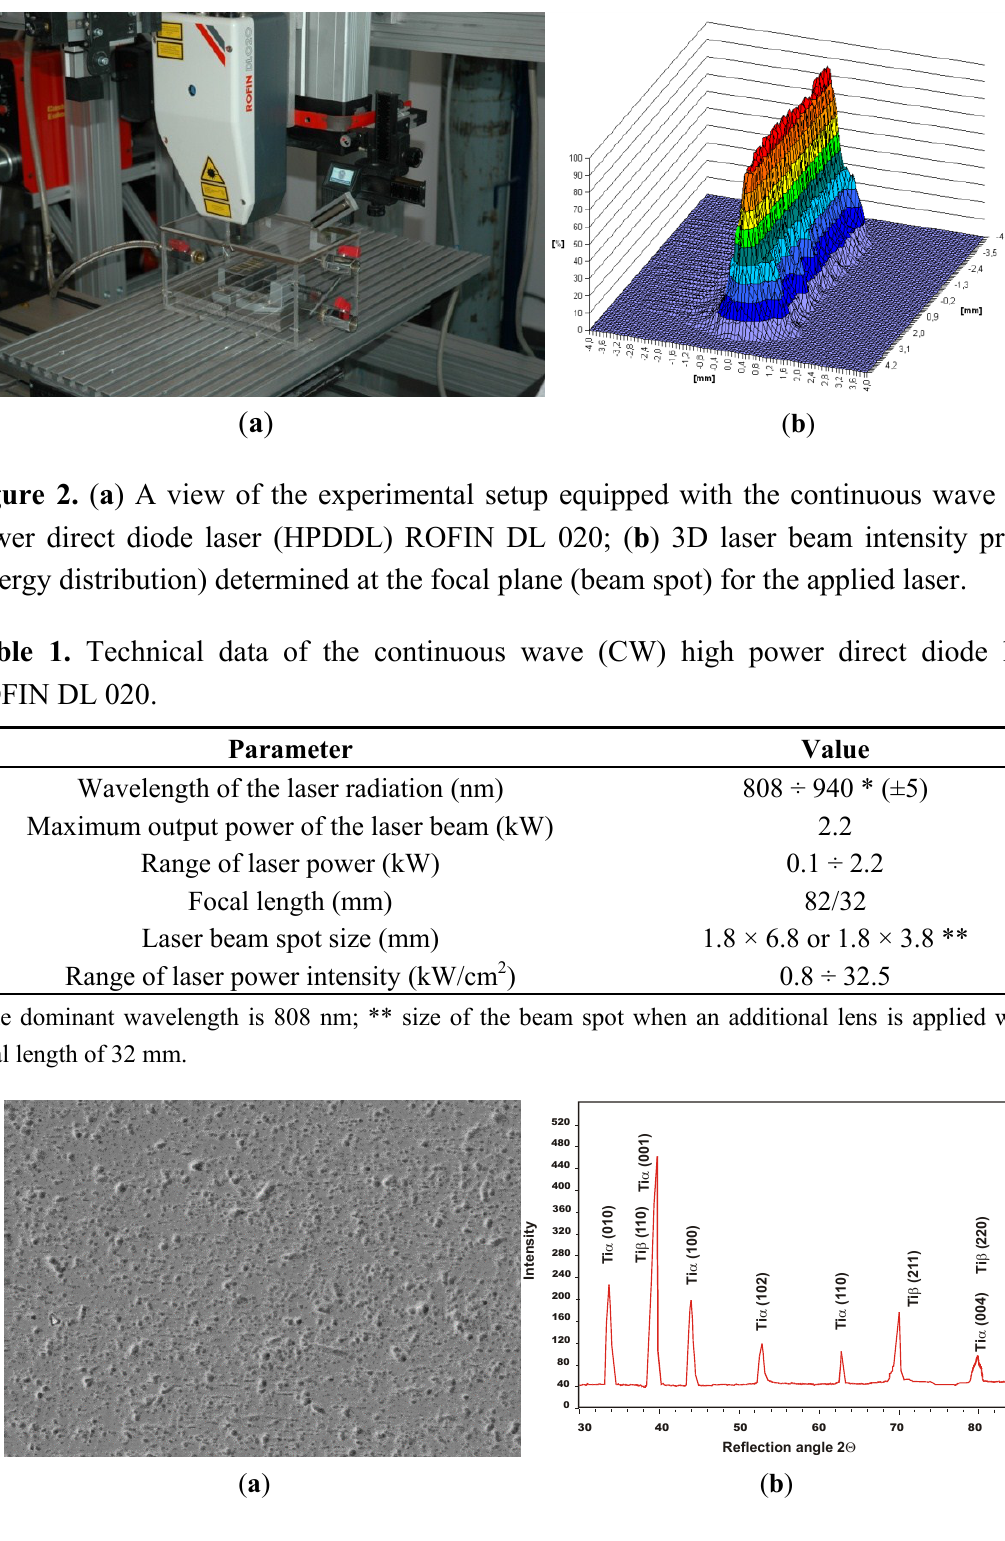
Figure 3. ( a ) Scanning electron micrograph (SEM) and ( b ) XRD spectrum of the as-received titanium alloy Ti6Al4V specimen 3.0 mm thick (α + β phases). The nitrided surface layers on titanium alloy specimens were produced as single stringer beads. The rectangular laser beam spot was focused on the top surface of specimens and set perpendicularly to the direction of scanning. Laser gas nitriding (LGN) tests of the titanium alloy Ti6Al4V surface